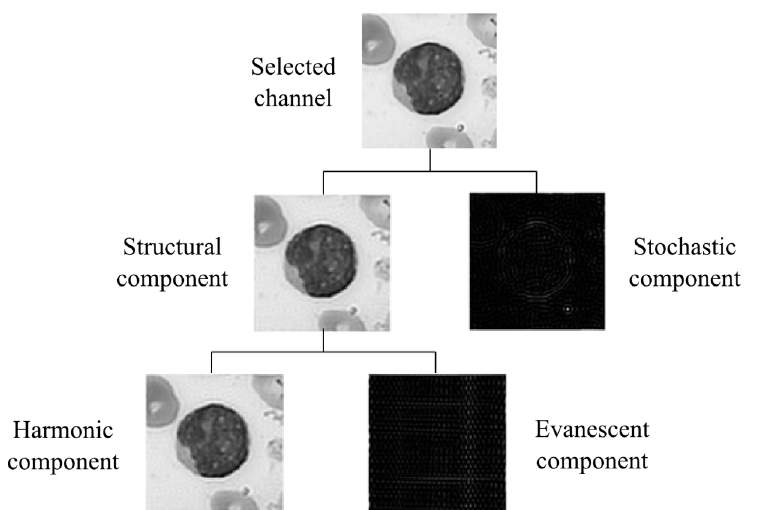
Fig 4. Wold's decomposition texture